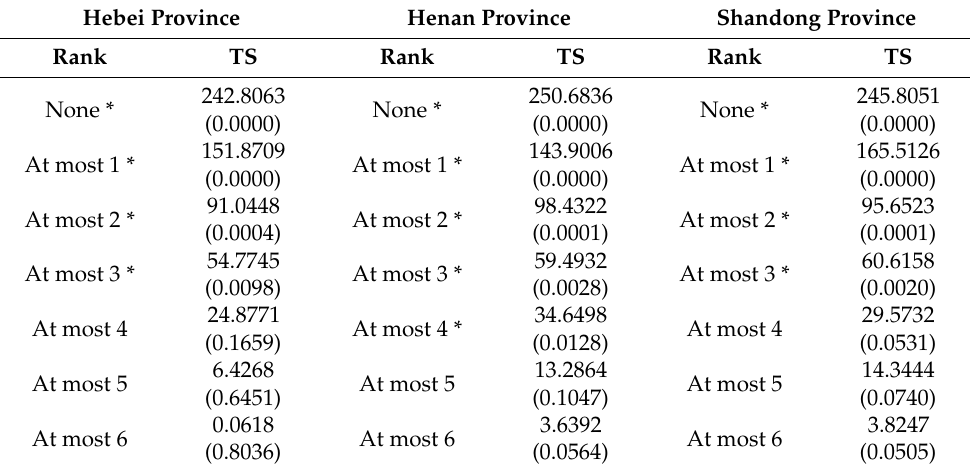
Table 3. Co-integration outcomes for Hebei, Henan, and Shandong